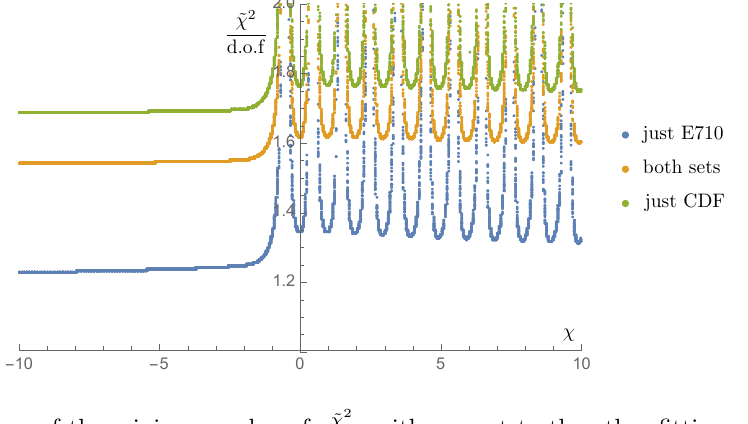
with respect to the other (cid:12)tting parameters, for d : o : f